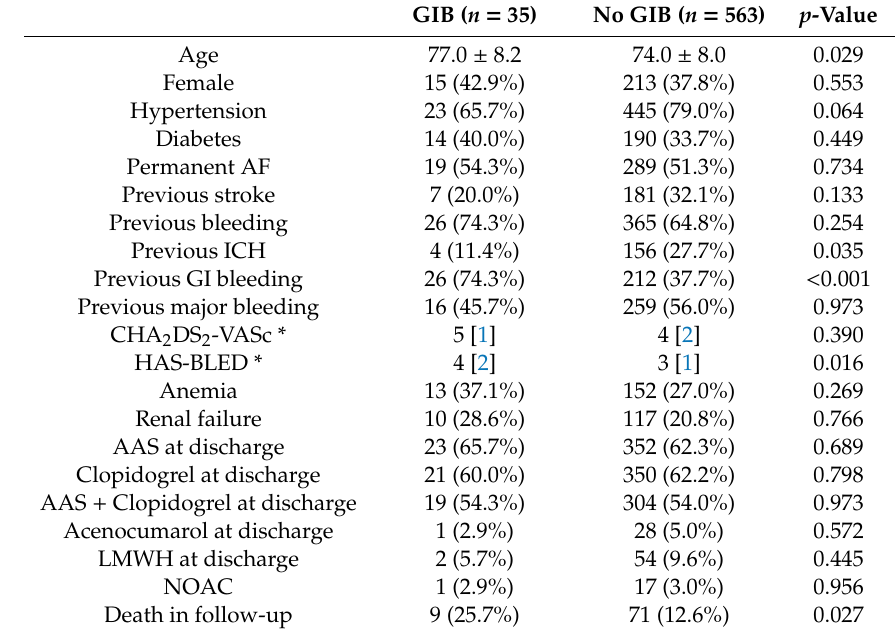
Table 5. Comparison of the main variables in patients presenting GIB events or no GIB events during follow-up.